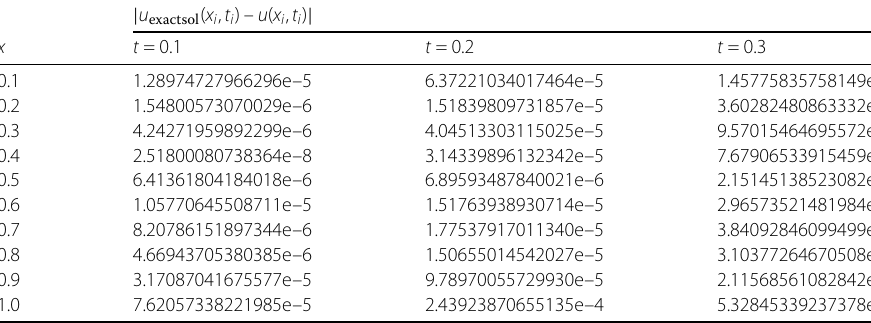
Table 6 Comparison of maximum absolute errors acquired using the GWGM for β = 3/2, α = 1 of Example 2 with given initial and boundary